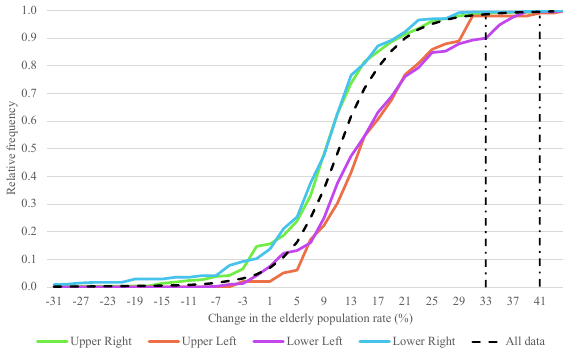
Figure 15 . Cumulative relative frequency of the changes in the elderly population rate between 2000 and 2015. The legend except “All data” is based on Table 1.